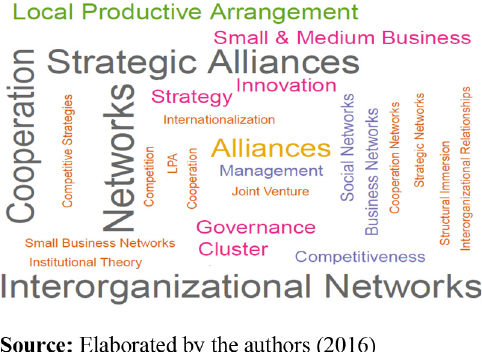
Figure 4. Cloud made